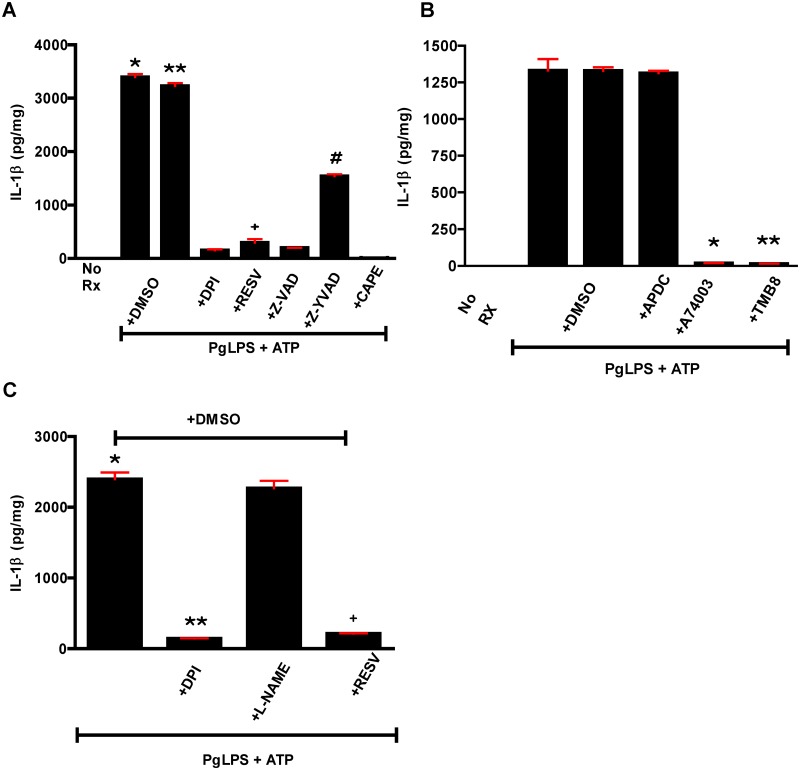
Inhibitor studies show that PgLPS mediated generation of IL1β is dependent upon inflammasome activation.
A-C. NFκB nuclear translocation was blocked by CAPE; caspase1 activation was inhibited by the pan-caspase inhibitor Z-VAD-FMK and the specific inhibitor, Z-YVAD-FMK. Inhibitors and scavengers of ROS included DPI, resveratrol (RESV), APDC and L-NAME. Only those that inhibited NADPH oxidase affected IL1β generation. Blocking internal calcium stores release (TMB8) or the P2X7 potassium efflux channel (A740003) also inhibited IL1β generation. These data are consistent with inflammasome activation. A. One way ANOVA, p< 0.0001. Bonferroni’s Multiple Comparison Test, p<0.05. *, **PgLPS+ATP or PgLPS+ATP+DMSO vs no Rx, +DPI, +RESV, +Z-VAD, +Z-YVAD, +CAPE. +PgLPS+ATP+RESV vs no Rx, +CAPE. # PgLPS+ATP+Z-YVAD vs DPI, +RESV, +Z-VAD, +CAPE. B. One way ANOVA, p< 0.0001. Bonferroni’s Multiple Comparison Test, p<0.05. *,**PgLPS+ATP+A740003 or PgLPS+ATP+TMB8 vs all groups except no Rx. C. One way ANOVA, p< 0.0001. Bonferroni’s Multiple Comparison Test, p<0.05. *PgLPS+ATP+DMSO vs all other groups except +L-NAME. ** PgLPS+ATP+DMSO+DPI vs all other groups except PgLPS+ATP+DMSO+RESV. +PgLPS+ATP+DMSO+RESV vs all other groups except PgLPS+ATP+DMSO+DPI. Experiments were done in quadruplicate and repeated twice.